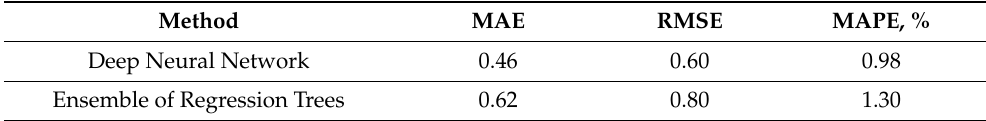
Table 5. Comparative characteristics of the work of the implemented methods on a test sample in determining the cubic compressive